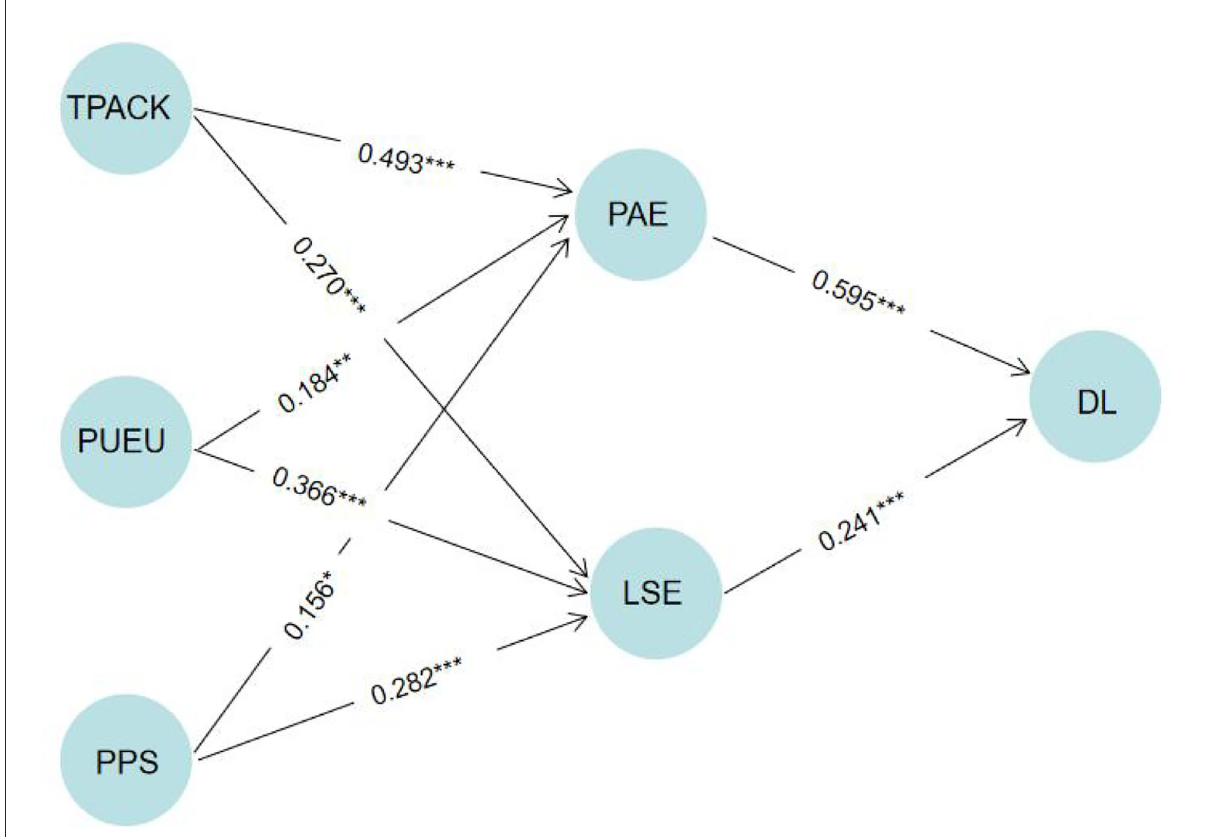
FIGURE3 Significance of effects path. * p < 0.05, t > 1.645; ** p < 0.01, t > 2.327; *** p < 0.001, t >